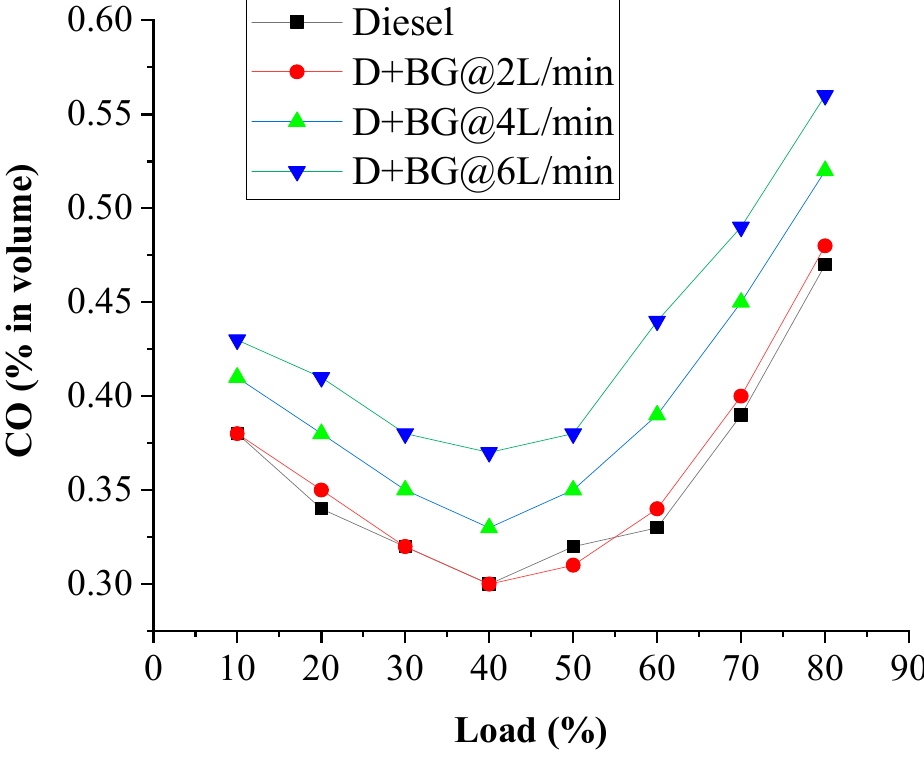
Figure 7. Variation of CO with respect to load.